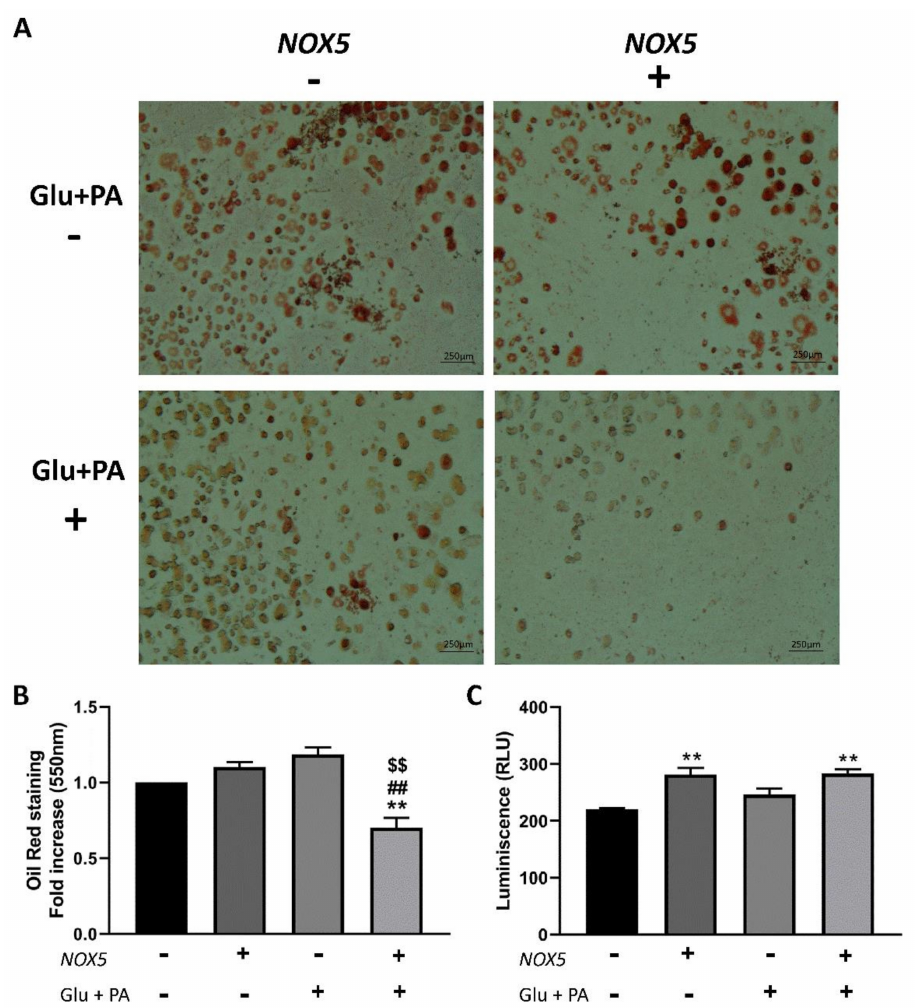
Figure 6. 3T3-L1 adipocytes showed a reduction of lipid accumulation when incubated for 24 h with glucose (Glu) + palmitic acid (PA) conditioned media from NOX5-expressing endothelial bEnd.3 cells and an increase of glucose uptake even without the previous incubation with Glu + PA. ( A ) Representative images of Oil Red staining ( n = 3). ( B ) Oil Red quantification at 550 nm ( n = 3). ( C ) Glucose uptake quantification of 3T3-L1 adipocytes through luminescence after stimulation with 100 nM insulin. Fold increase is relative to the control group (Nox( − )/Glu + PA( − )). Values are expressed as mean ± SEM. ** p < 0.01: differences relative to Nox( − )/Glu + PA( − ); ## p < 0.01: differences relative to Nox(+)/Glu + PA( − ); $$ p < 0.01: differences relative to Nox( − )/Glu + PA(+). Statistical test used: